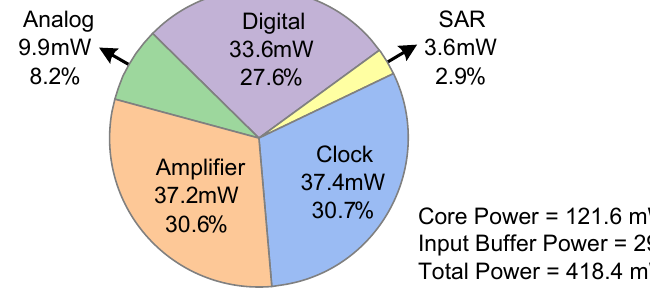
Figure 11. Measured core power breakdown.